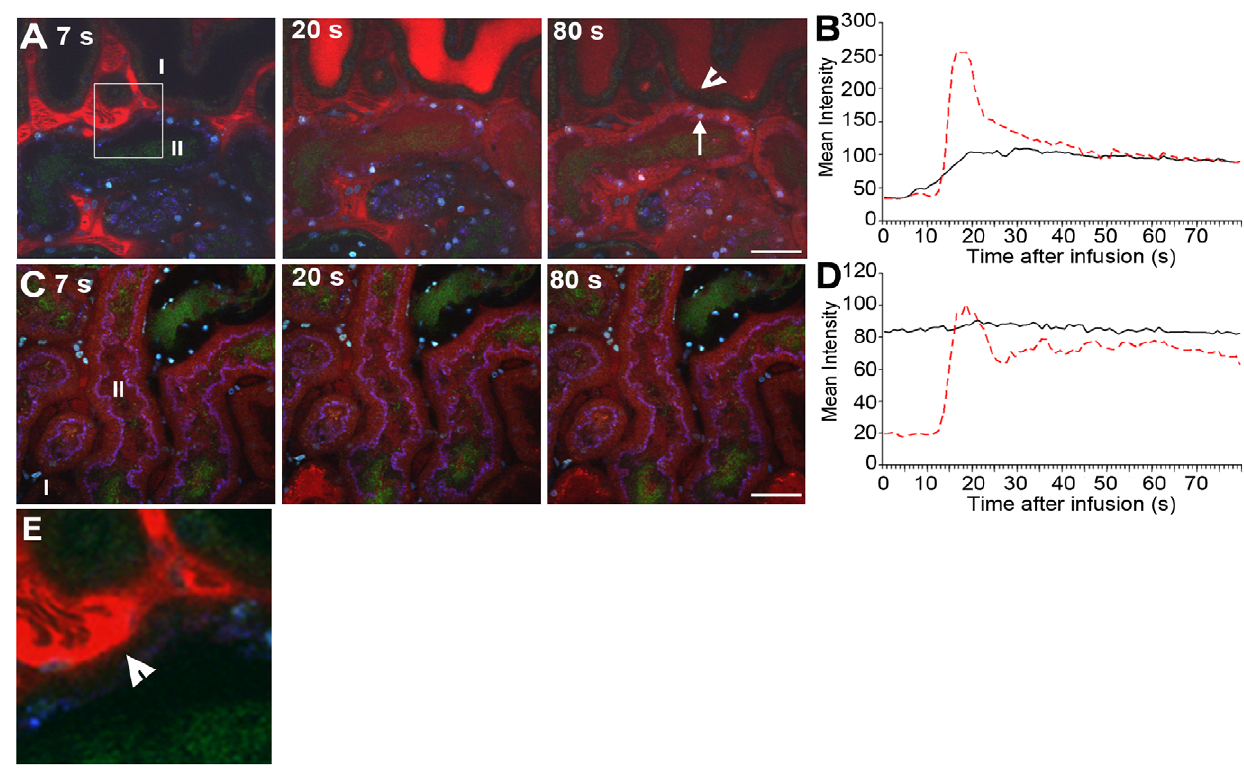
Figure 5. Infection affects renal filtration. Glomerular filtration in non-infected (I) and infected (II) tubules 4 h (A,B) and 8 h (C, D) after LT004 infusion is visualized 7, 20, and 80 s after iv bolus infusion of 10 kDa dextran (red). These data sets are representatives from a single animal, the experiments were performed on at least 3 separate occasions. The dynamic aspect of renal filtration and clearance can be seen in Videos S2 and S3, from which these frames originate. ( A ) Efficient filtration of the non-infected nephron (I) is visualized by the appearance of the bright red dextran in the tubule lumen (20 s), followed by a drop in intensity (80 s) indicating clearance. A less dramatic intensity change is seen in the infected nephron, indicating less filtration. Epithelial dextran uptake (arrow, 80 s) indicates epithelial dysfunction in infected tubule. Healthy epithelia in non-infected tubule exclude the dextran (arrowhead, 80 s). ( B ) Quantification of the mean intensity of dextran in tubule lumens over 80 s. Dotted red line corresponds to luminal intensity in the non-infected tubule (I), black line corresponds to the infected tubule (II). ( C–D ) The absence of filtrated dextran in the infected tubule (II) demonstrates compromised filtration at 8 h. Tissue shows accumulation of some dextran from previous bolus infusions. Scale bars =30 m m. ( E ) Enlarged 50 m m inset from 5A 7 s showing dextran leaking into epithelial cells (arrowhead) from the basal side of the cells.